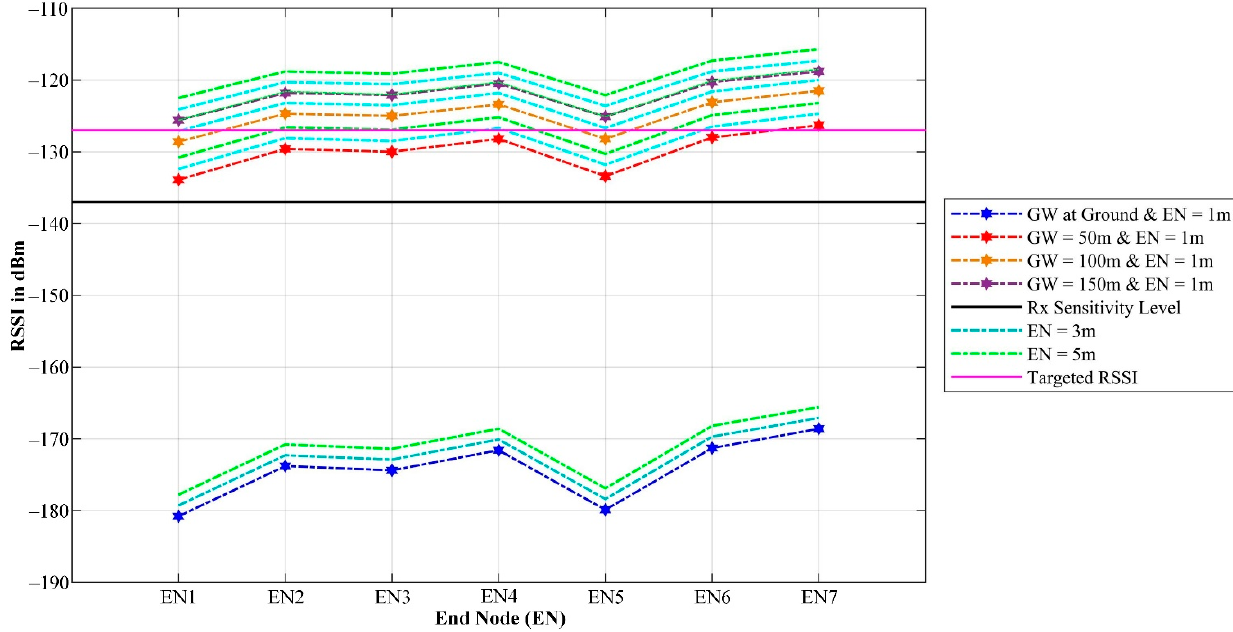
Figure 18. Predicted RSSI using the fine-tuned ITM PL model in Cloud-RF ® with various GW and EN height configura- tions.